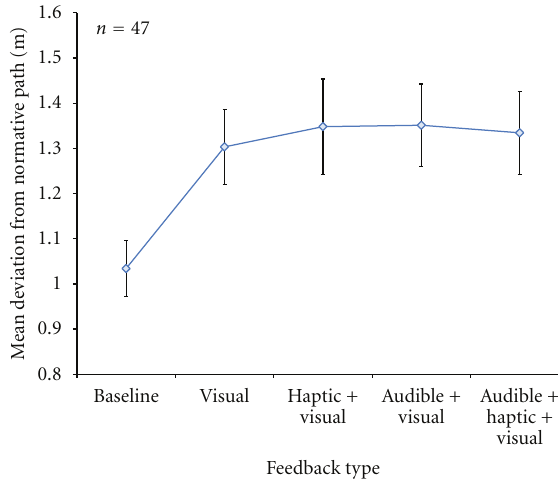
Figure 8: E ff ect of feedback type on mean Deviation